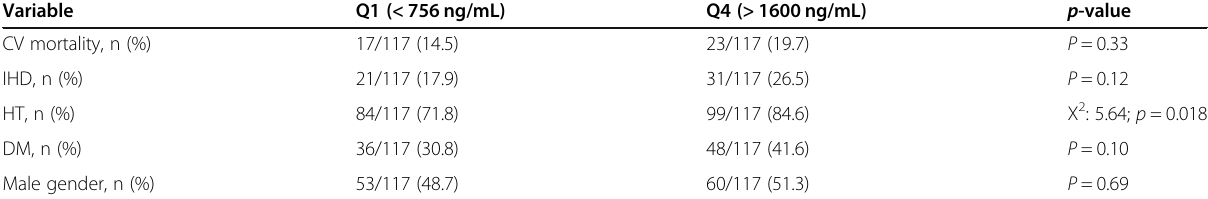
Table 4 Relation of different variables in the 1st and the 4th quartile of plasma concentration of TSP1 in the study population Variable Q1 (< 756 ng/mL)